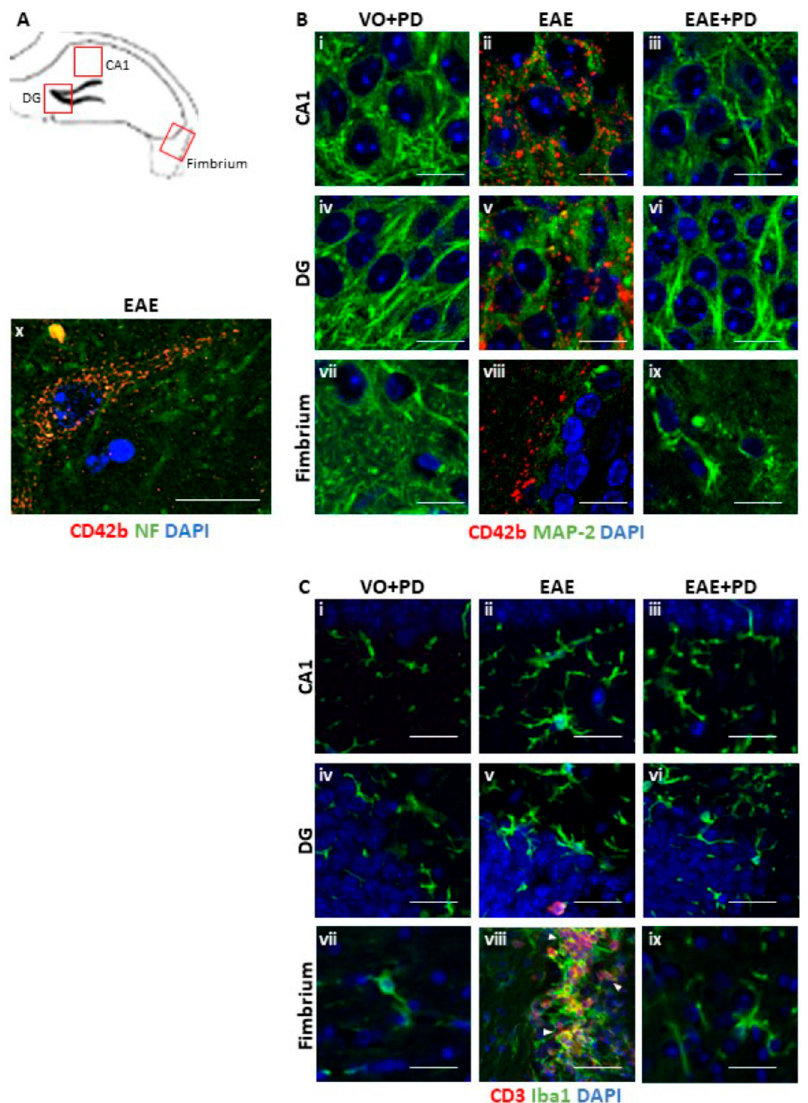
Figure 4. Immunochemical analysis of platelet accumulation and immune cell infiltration in the hippocampus. Following EAE induction, mice received a single administration of platelet depletion antibody (EAE + PD) or isotype control (EAE) at 7 dpi and were exposed to the EPM at 9 dpi, with n = 8 mice/group. An additional control consisted of PD-treated vehicle-only mice (VO + PD). Half of each cohort was killed at 9 dpi and the other at 14 dpi and sections (14 µ m thick) challenged with anti-CD42b (red) + anti MAP-2 (green) ( Bi to Bix ), or anti-CD42b (red) + anti NF (green) ( Bx ), or anti-CD3 (red) + anti-Iba1 (green) ( C ). Nuclei were stained with DAPI. ( A ) shows the regions of interest. Platelets were observed in the fimbrium and in close association with neuronal cell bodies in the CA1 region and dentate gyrus (DG) only in EAE mice ( Bii , Bv , and Bviii ), but not in VO + PD ( Bi , Biv , and Bvii ) and EAE + PD mice ( Biii , Bvi , and Bix ) at 14 dpi ( Bi to Bix ) and 9 dpi ( Bx ). ( Bx ) shows a single platelet-associated neuron in the CA1 region in an EAE mouse at higher magnification. T lymphocyte infiltration was not observed in the CA1 region ( Ci – Ciii ) and dentate gyrus ( Civ – Cvi ) over the whole time course. It was evident in the fimbrium ( Cviii ), but not the CA1 region ( Cvii ) and dentate gyrus ( Cix ) by 14 dpi. Scale bars = 10 µ m. EAE = experimental autoimmune encephalomyelitis, EPM = elevated plus maze, VO = vehicle only, PD = platelet depletion, MAP-2 = microtubule-associated protein 2, NF = neurofilament protein, DAPI = 4 (cid:48) ,6 diamidino-2-phenylindole; CA1 = cornu ammonis region